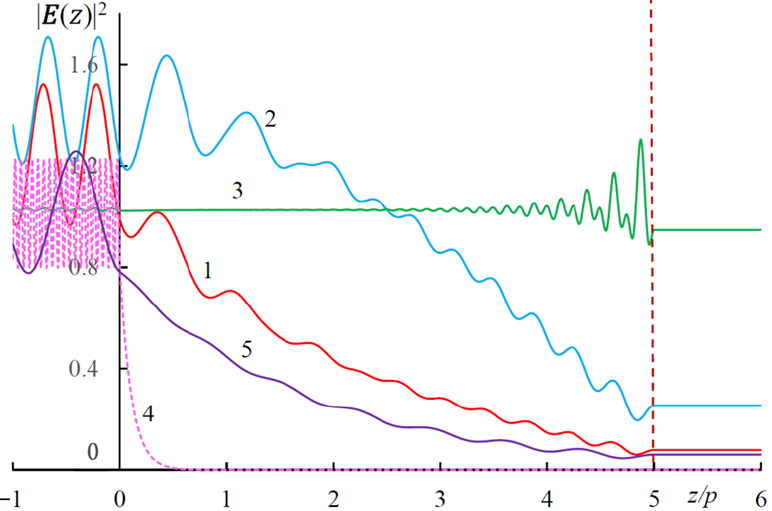
Figure 10. The dependences | E ( z ) | 2 for the following characteristic wavelengths: (1) λ 0 = 282.8 nm; (2) λ r = 267 nm; (3) λ t = 89.4 nm; (4) λ = 30 nm << λ 0 ; (5) λ = 500 nm >> λ 0 .